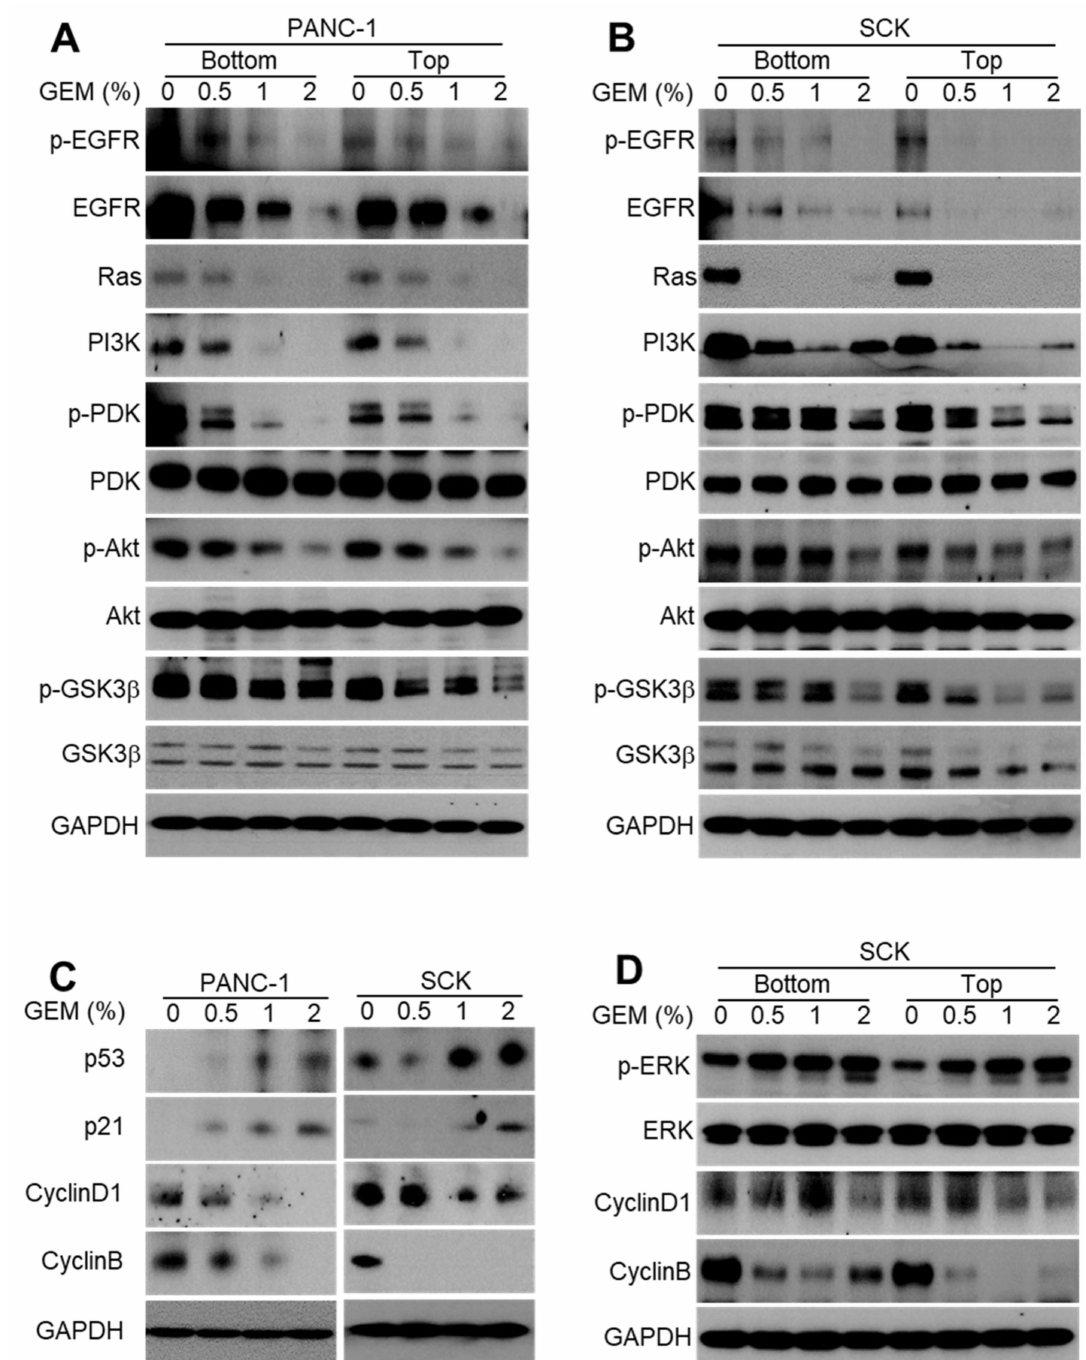
Figure 2. Gemcitabine-eluting membrane (GEM) implantation inhibits EGFR signaling in xenograft tumors. ( A , B ) Western blot analysis of phospho-EGFR, EGFR, Ras, PI3K, phospho-PDK, PDK, phospho-AKT, AKT, phospho-GSK3 β , and GSK3 β at the bottom and top of the indicated tumors from the GEM-implanted and control groups. ( C ) p53, p21, cyclin D1, and cyclin B expression was evaluated by Western blot analysis in SCK and PANC-1 tumors after implantation of the GEM containing the indicated concentrations of gemcitabine. ( D ) Proteins derived from tumor lysates obtained from the bottom and top of SCK tumors were subjected to Western blot analysis using the indicated